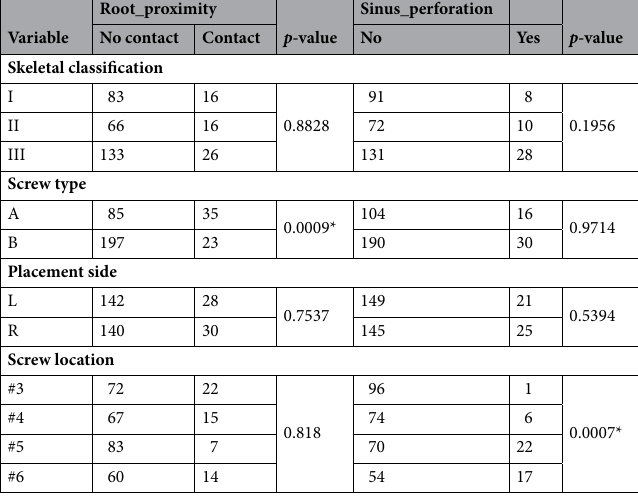
Table 2. Root proximity and sinus perforation according to each variable. L left, R, right; #3 Canine, #4 1st premolar, #5 2nd premolar, #6 1st molar. * p < 0.05.